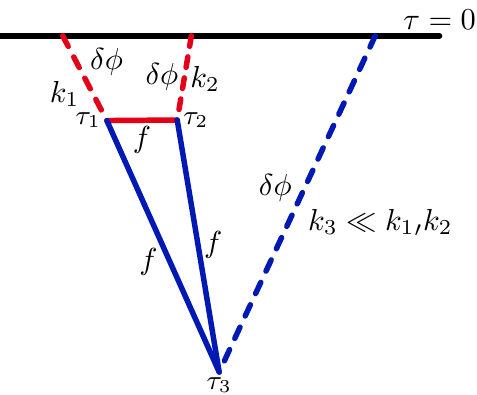
Figure 4 . Feynman diagram for the contribution to the 3-point function of the in(cid:13)aton from a loop of SM fermions. Two SM fermions f are produced at an early time (cid:28) 3 through an interaction with a soft in(cid:13)aton (cid:13)uctuation (cid:14)(cid:30) , and annihilate at later times (cid:28) 1 , (cid:28) 2 producing two hard in(cid:13)aton legs with k 1 ; k 2 (cid:29) k 3 . The time propagation of the fermions f is at the origin of the non-analytic term in the bispectrum of the